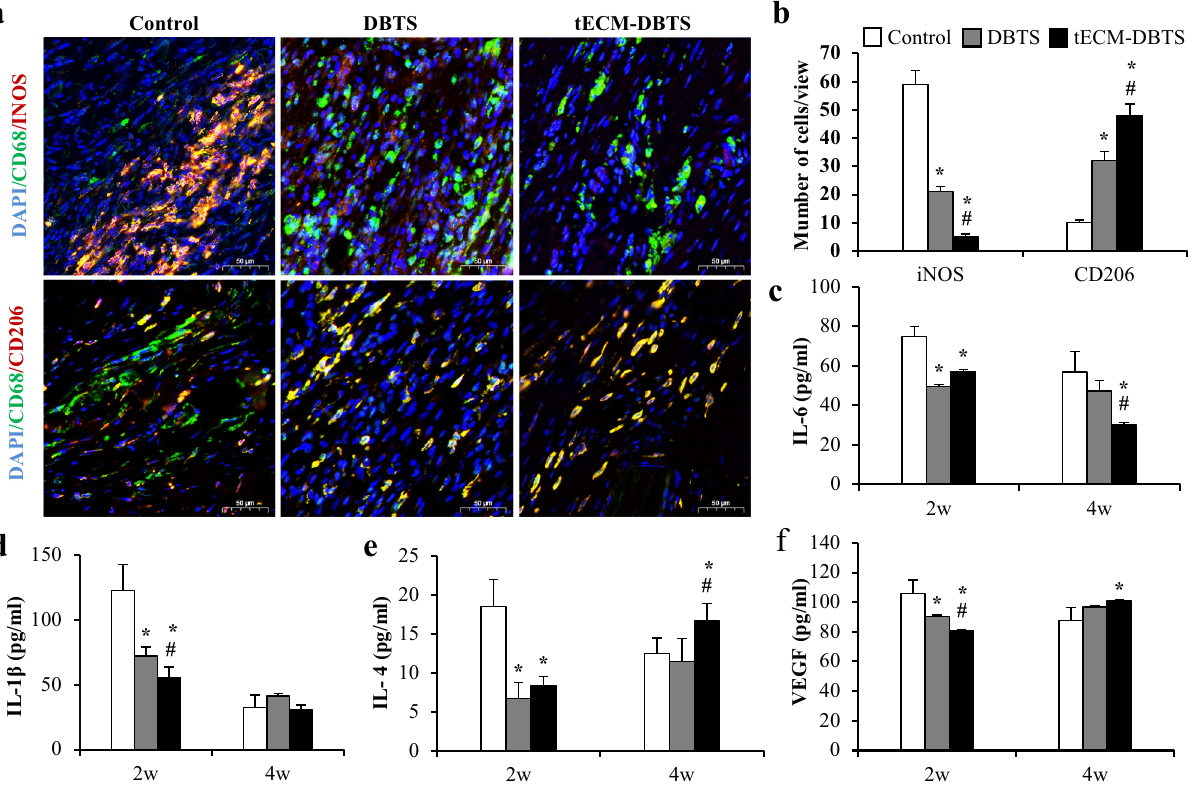
Fig. 5 Macrophage response during early remodeling stage. a Double staining showed the distribution of the CD68 positive pan- macrophage (green) and CD206-positive M2 type macrophages (red), or iNOS-positive M1 type macrophages (red) at 2 weeks. b Amount of CD68, CD206 and iNOS-positive cells was computed ( n = 5). The dynamic changes of cytokines and angiogenic factor expression were detected by ELISA, including IL-6 ( c ), IL-1 β ( d ), IL-4 ( e ), VEGF (f) ( n = 3). *Signi fi es a p < 0.05 as compared to the control. # Signi fi es a p < 0.05 as compared to the DBTS. Scale bars, a: 50 μ